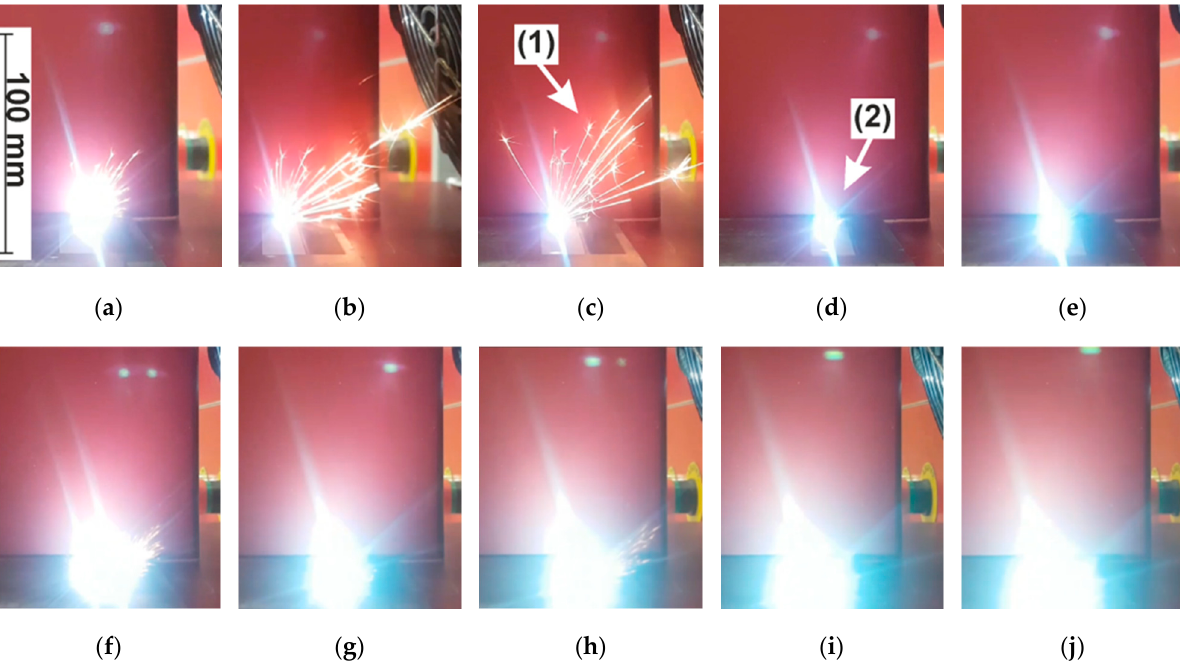
Figure 2. Splitting the video into frames of the experiment to establish the nature of the interaction of pulsed laser radiation with the metal surface. ( 1 ) Melt droplets flying out of the processing area. ( 2 ) Glow of metal vapors. Frames at different times: ( a ) 1 s, ( b ) 2 s, ( c ) 3 s, ( d ) 4 s, ( e ) 5 s, ( f ) 6 s, ( g ) 7 s, ( h ) 8 s, ( i ) 9 s and ( j ) 10 s.